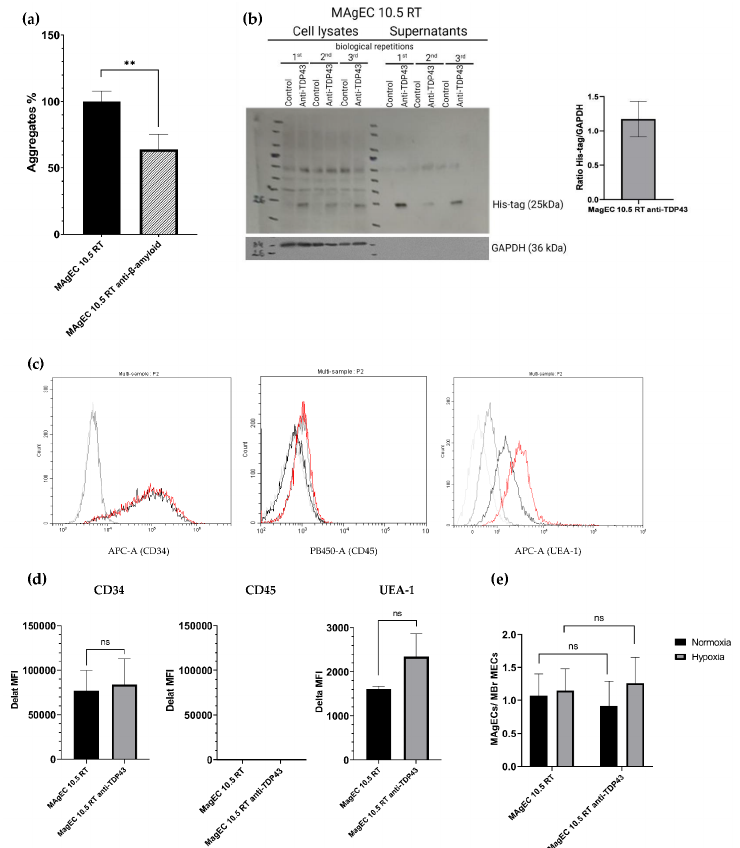
Figure 4. Characterization of the MAgEC 10.5 RT anti- β -amyloid and MAgEC 10.5 RT anti-TDP-43 cells: solubilizing Fab production and cell markers. ( a ), Solubilization capacity of anti- β -amyloid Fabs produced and secreted by the Fab-producing MAgEC 10.5 RT anti- β -amyloid cells. Superna- tants from these cells were tested in vitro on human β -amyloid aggregates. n = 3 per group. ( b ) Production and secretion of anti-TDP-43 Fab using Western Blot. Fabs are expressed and secreted by the Fab-producing MAgEC 10.5 RT anti-TDP-43 cells. The cell lysates and equal amount of medium from subconfluent cultures after 72 h of culture were used for analysis. The GAPDH was used as control. The densitometry analysis shows the ratio between His-tag and GAPDH in MAgEC 10.5 RT anti- TDP-43 from cell lysates. n = 3. ( c ) Flow cytometry analysis of MAgEC 10.5 RT and MAgEC 10.5 RT anti-TDP-43 cells. Grey lines for the three cell markers represent the unstained controls for the MAgEC 10.5 RT (light grey) and MAgEC 10.5 RT anti-TDP-43 cells (dark grey), respectively. Black lines represent expression in MAgEC 10.5 RT cells and red ones the expression on MAgEC 10.5 RT anti-TDP-43 cells surface. Both cell lines are CD34+, CD45- and bind UEA-1. Anti-CD45 labeling was validated using CD45+ cells by flow cytometry (Figure S2). ( d ) Comparative cell-marker expression of MAgEC 10.5 RT and MAgEC 10.5 RT anti-TDP-43 using flow cytometry. The quantitative expression of the markers is expressed in Delta MFI. No difference of expression is observed between the two cell lines, confirming that the Fab producing MAgEC 10.5 RT anti-TDP-43 retains the same phenotype. n = 3 per group. ( e ) Hypoxia sensitivity of murine brain-derived endothelial cells (MBrMECs) recognition by MAgEC 10.5 RT by adhesion experiment. The adhesion experiment was performed in proportion 1:1 for MAgECs/MBrMECs in two conditions: hypoxia (grey bars) or normoxia (black bars). After incubation of the MAgEC 10.5 RT or MAgEC 10.5 RT anti-TDP-43 suspension on MBrMECs layer, un-attached cells are removed and then the ratio of MAgEC 10.5 RT to MBrMECs is counted. MAgEC 10.5 RT anti-TDP-43 cells show no significant difference in adhesion capacity compared to the MAgEC 10.5 RT. n = 3 per group. Statistical differences were considered relevant at p < 0.05 (** p < 0.01), ns: not